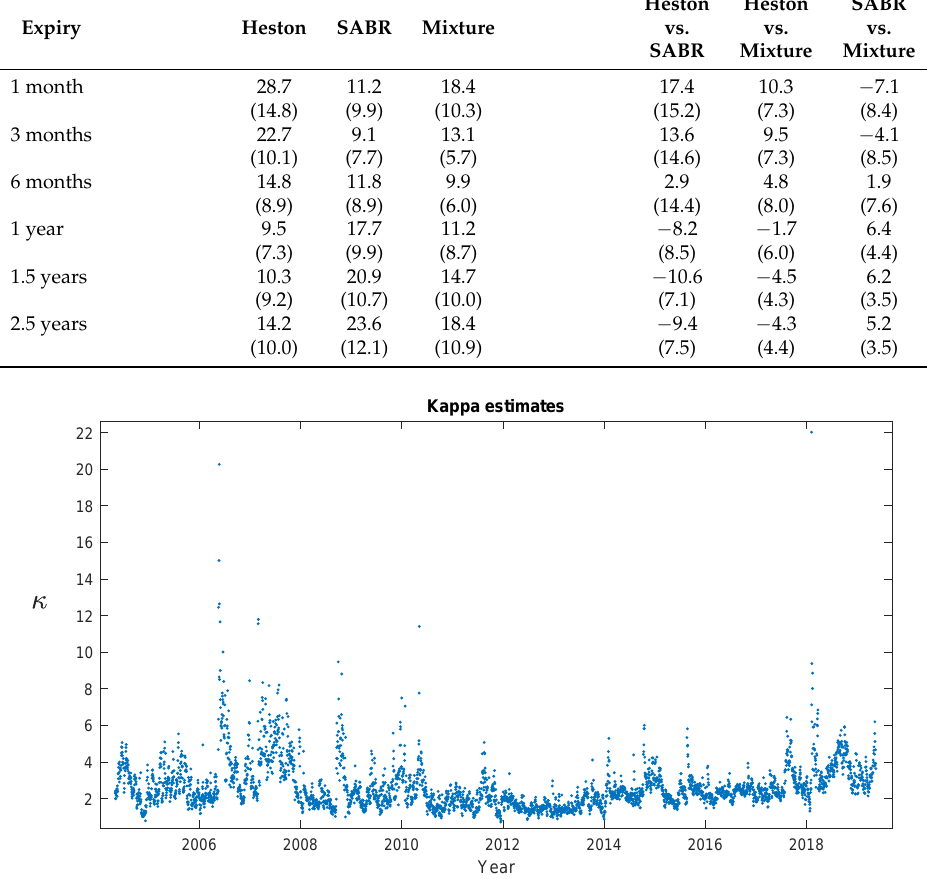
Table 3. The left part of the table shows average calibration errors in basis points. Standard deviations are shown in parentheses. The right part of the table shows the average of the per-day differences in calibration errors between each pair of models. I.e., the column “Heston vs. SABR” shows statistics on the time series constructed, where on each day we subtract the Heston error from the SABR (stochastic-alpha-beta-rho) error. Heston vs. Heston SABR Mixture